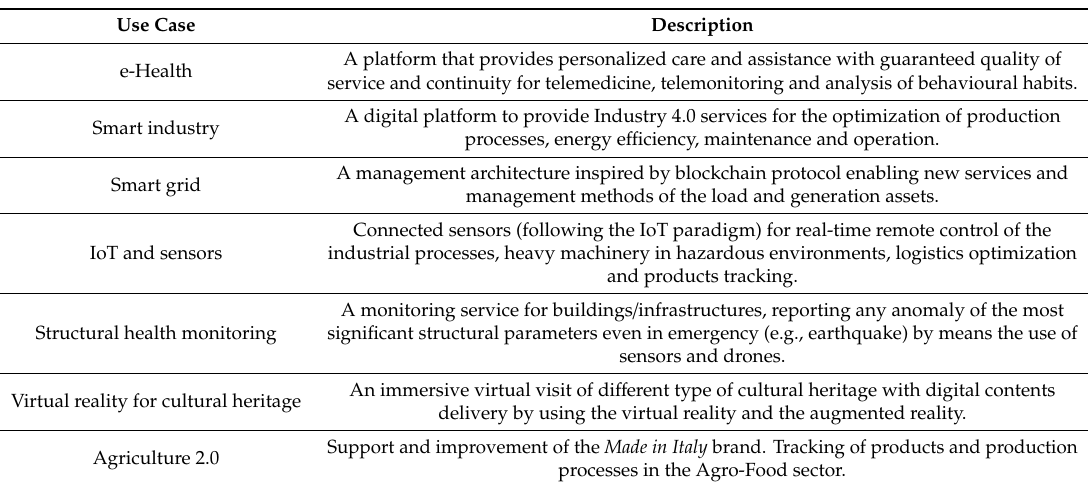
Table 1. 5G project Use